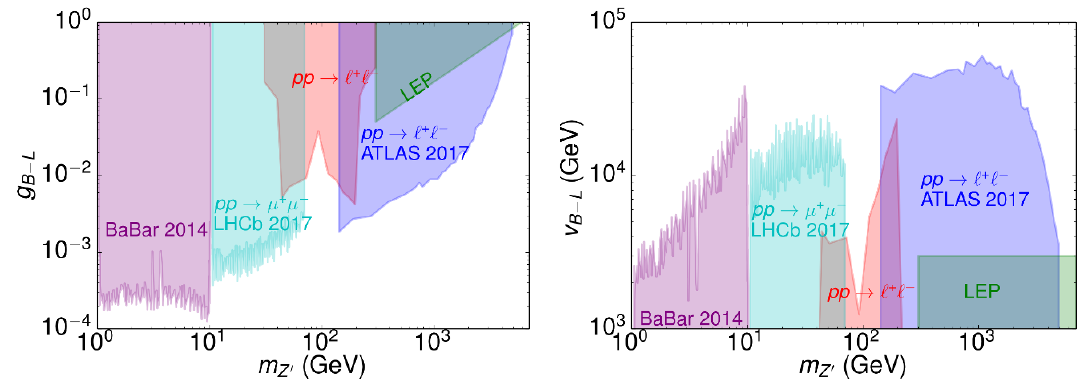
Figure 1 . Bounds from various collider experiments on the B coupling g B (cid:0) L (left) and the vev v B (cid:0) L